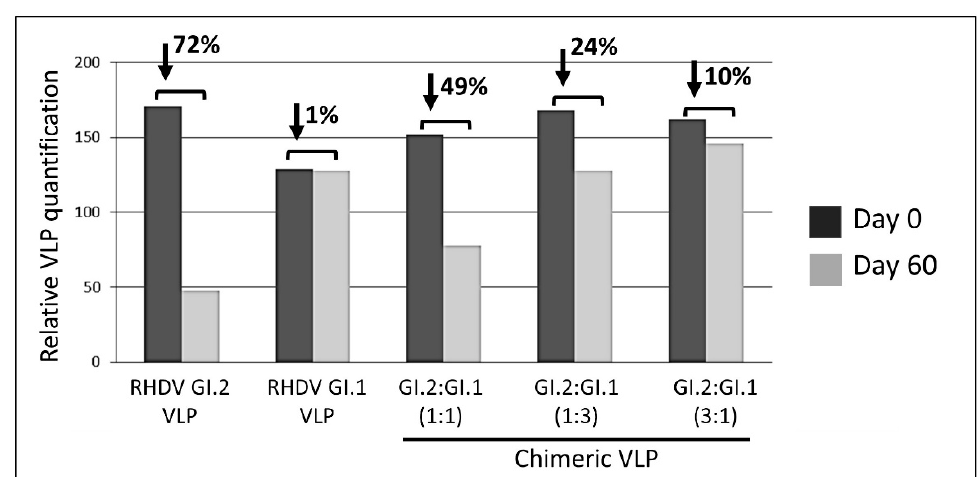
Figure 4. Stability after 2 months of storage of VLPs obtained with individual VP60 proteins and that obtained by co-infection with the two recombinant baculoviruses using different proportions as determined SDS-PAGE and by electron microscopy. RHDV GI.2-derived VLPs were not stable, while chimeric VLPs obtained at a RHDV GI.2/RHDV GI.1 ratio of 3:1 were similar in stability to the highly stable RHDV GI.1-derived VLPs.